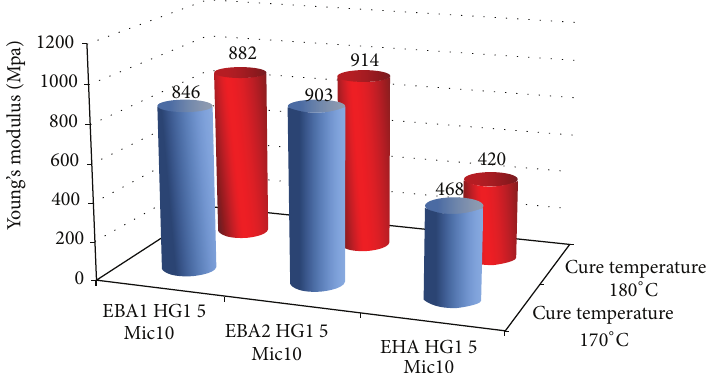
Figure 3: Young’s modulus of self-healing epoxy formulations at different curing temperature of 170 ∘ C and 180 ∘ C.